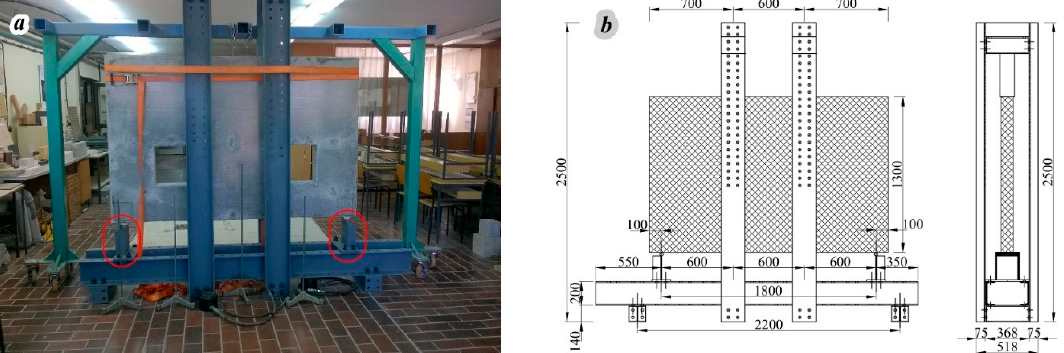
Figure 14. Steel frame for testing reinforced concrete members: ( a ) frame appearance and ( b ) geometric characteristics. Appl. Sci. 2020 , 10 , x FOR PEER REVIEW 19 of 37